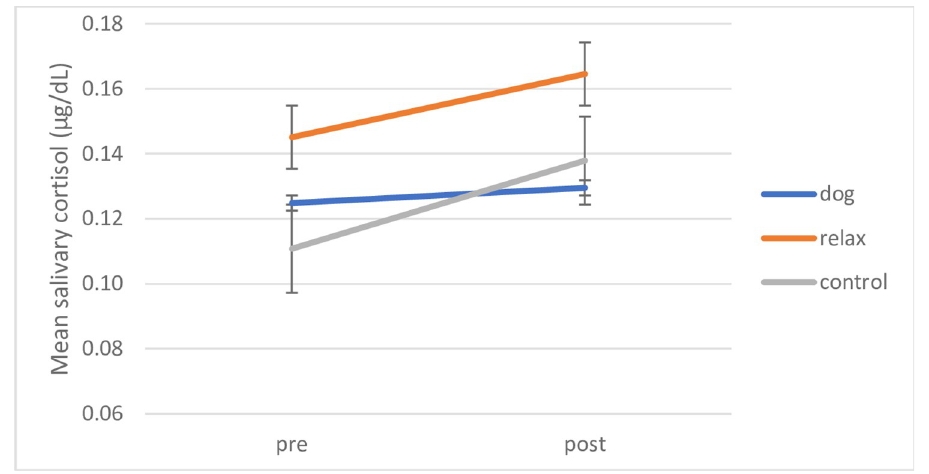
Fig 5. Group interventions: Mean pre-post salivary cortisol by intervention condition. Mean pre-post salivary cortisol levels shown by intervention condition. Error bars indicate standard error of mean.